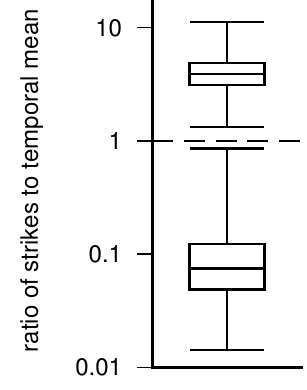
Fig. 2. Maximum-to-mean ratio (top box plot) and minimum-to- mean ratio (bottom box plot) for ALDS strike data in June between 1986 and 2010, based on approx. 1750 grid cells with more than 5yr of